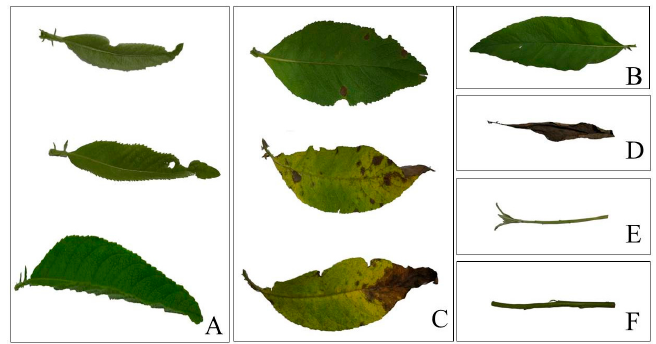
Table 5. Soil characteristics of the experimental site used in the present study.